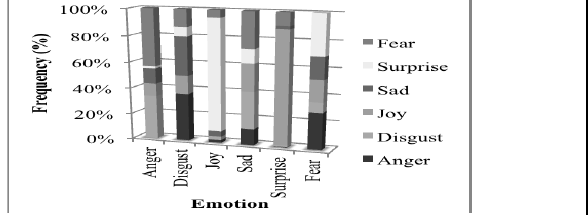
Figure 3. Frequencies (%) of 2 emotions per concept